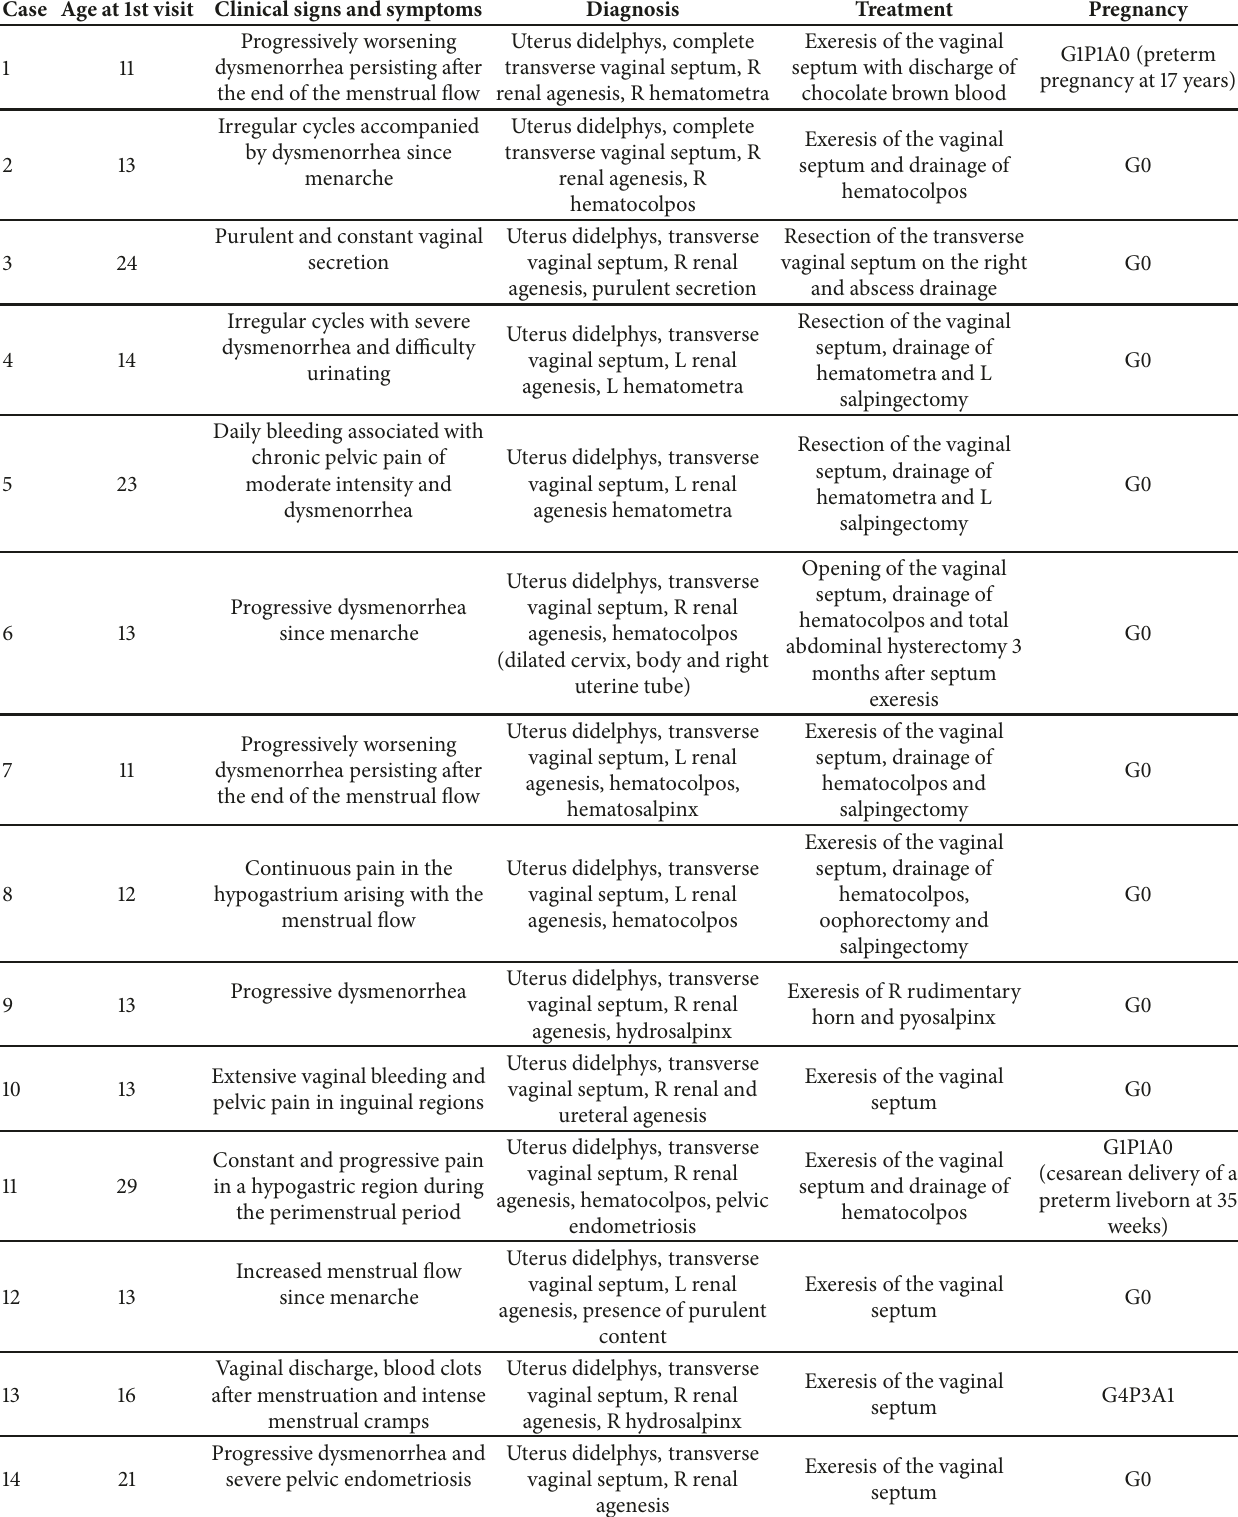
Table 1: Description of the 14 cases of diagnosed